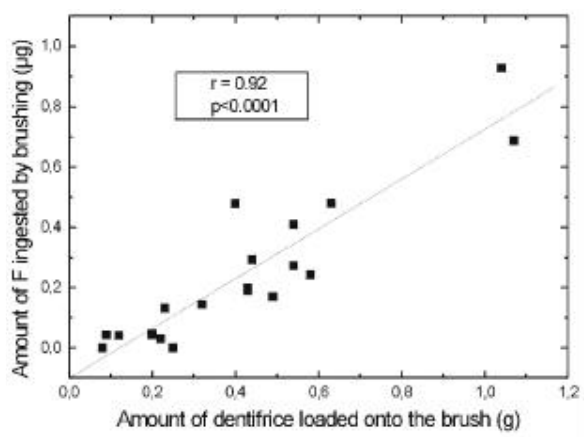
FIGURE 2- Correlation between the amount of dentifrice loaded onto the brush and the amount